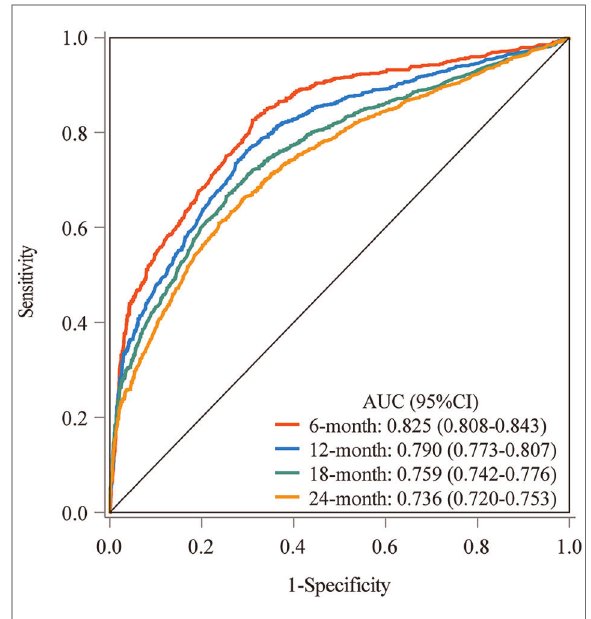
FIGURE 3 The AUCs of the model for predicting the overall survival of metastatic ovarian cancer patients at different time points in the training set.